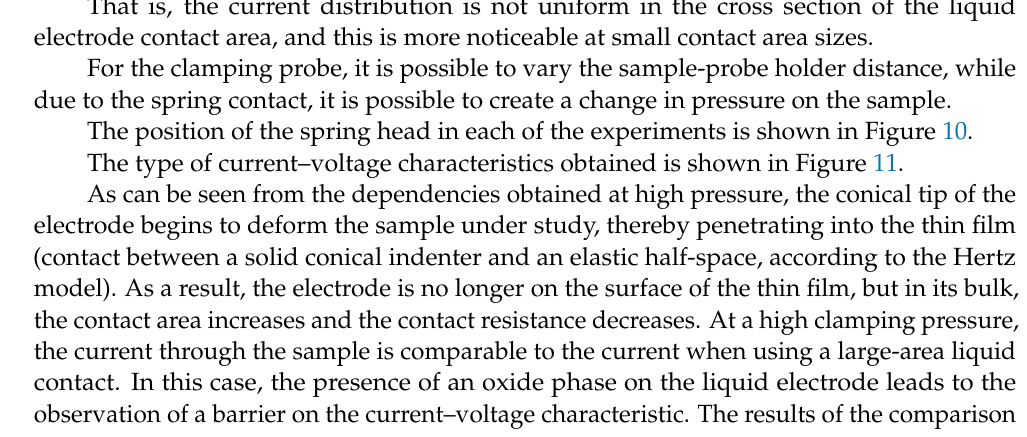
Figure 10. Rigid electrode positions exerting different clamping pressure on the surface Pa< Pb < Pc. The type of current–voltage characteristics obtained is shown in Figure 11.